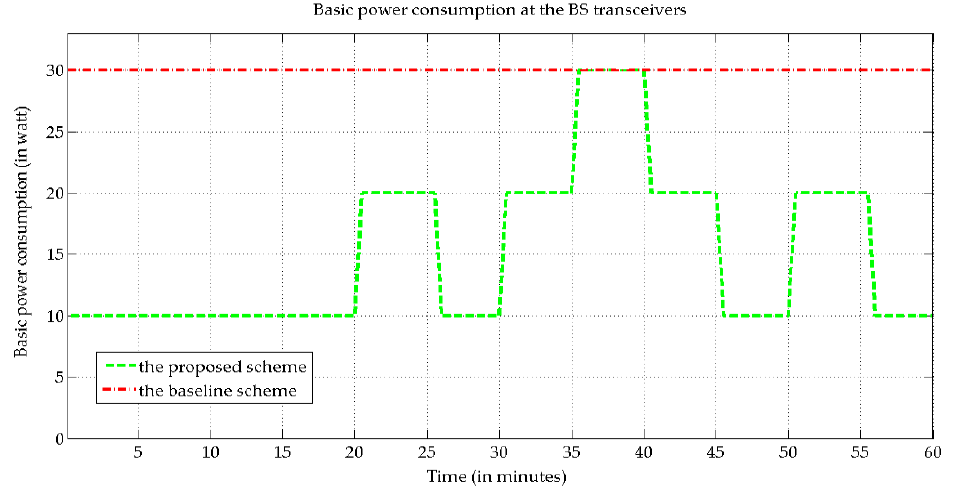
Figure 6. A comparison of the levels of basic power consumption for the proposed scheme and the conventional scheme. Energies 2016 , 9 , 265